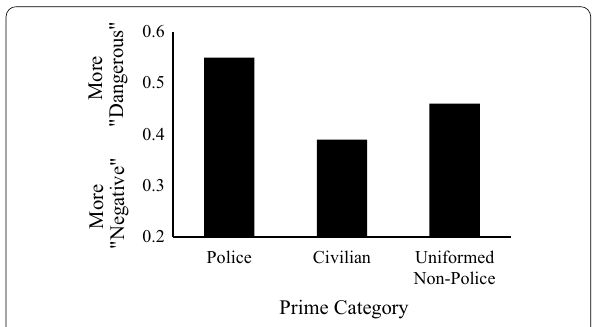
Fig. 3 Mean danger versus negative evaluations by prime